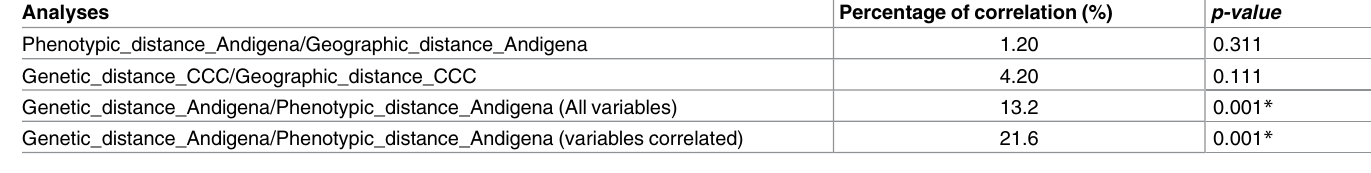
* Significance at p (cid:20) 0.05 at 1000